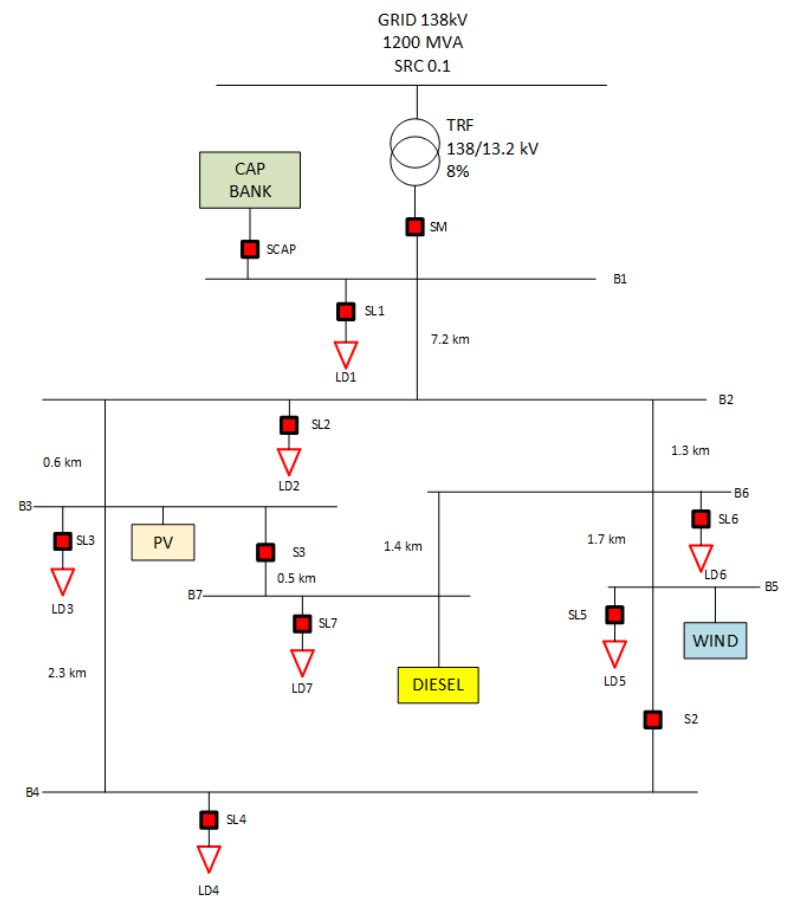
Figure 4. Simulated Microgrid.